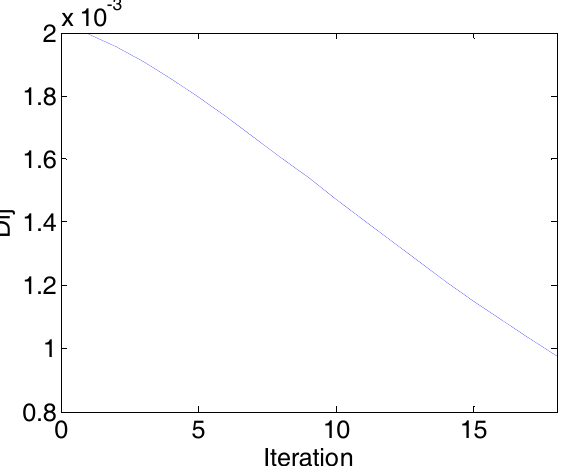
Figure 6. The convergence diagram of the PN algorithm (corn data): Iterations vs. D ij ( D ij is the rate of change of the network continuity). When the iteration is 18, all the D ij are smaller than the threshold of stop, and the network is converged.